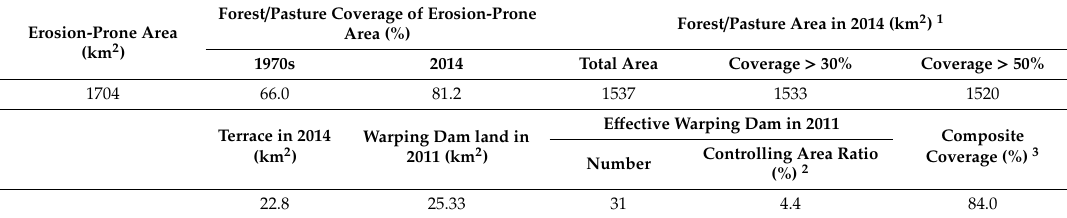
Table 1. Statistics of soil and water conservation (SWC) measures in the Yunyan River Basin (Liu [28]). Erosion-Prone Area (km 2